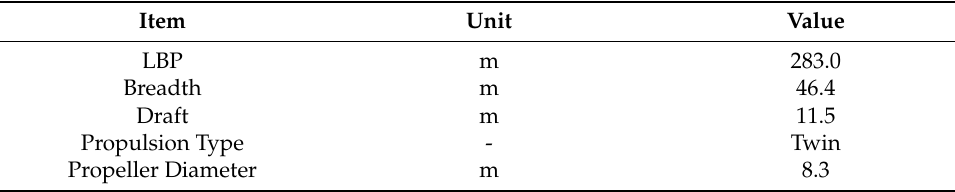
Table 2. Principal dimension of 173 K LNG Carrier.